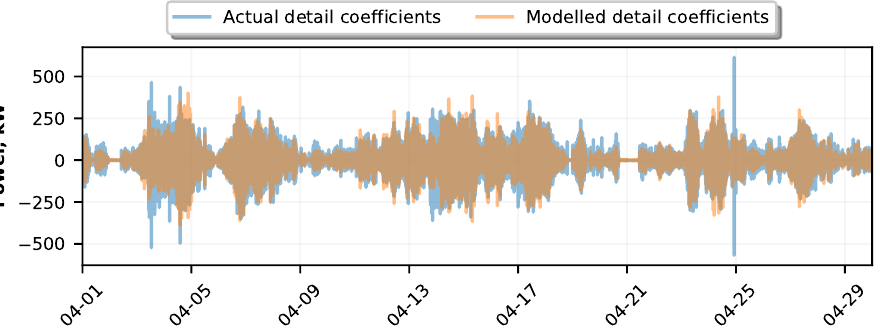
Figure 6. Power production detail coefficients at scale 2 between 8 aggregated WTGs (actual) and model power production using surrogate